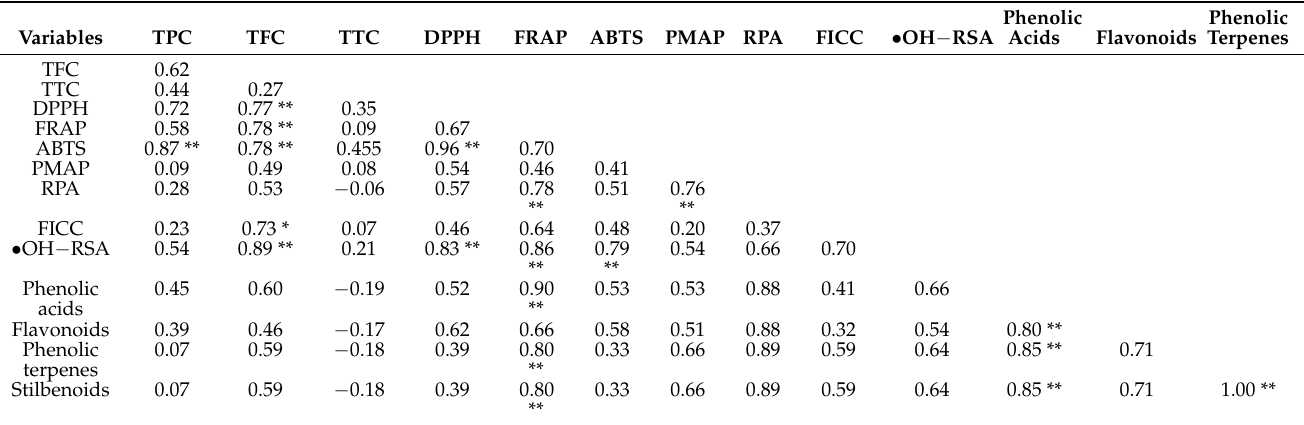
Table 4. Pearson’s correlation between polyphenolic contents in herbs and their different anti-oxidant activities. Variables